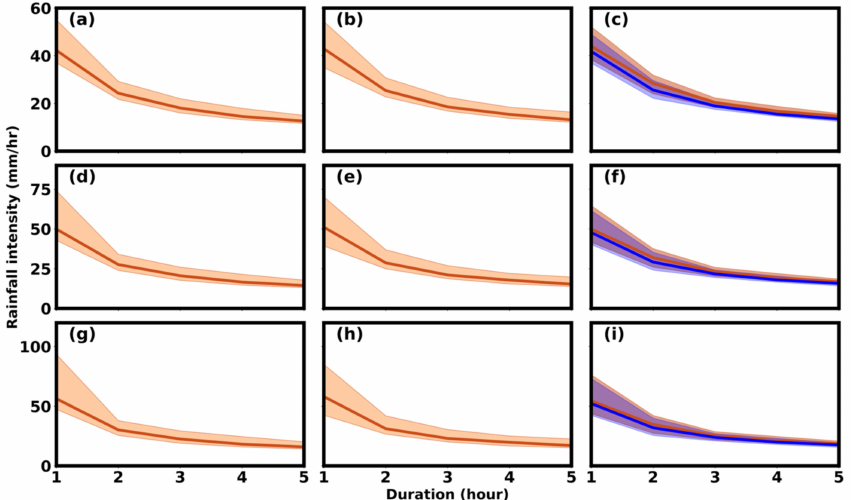
Figure 8. IDF relationships for the three zones across Bangalore (as the columns): ( a , d , g ) Zone 1, ( b , e , h ) Zone 2, and ( c , f , i ) Zone 3. Rows represent the three return periods: ( a – c ) 10, ( d – f ) 25, and ( g – i ) 50 years. Zone 1 and Zone 2 do not have any KSNDMC stations with non-stationarity in